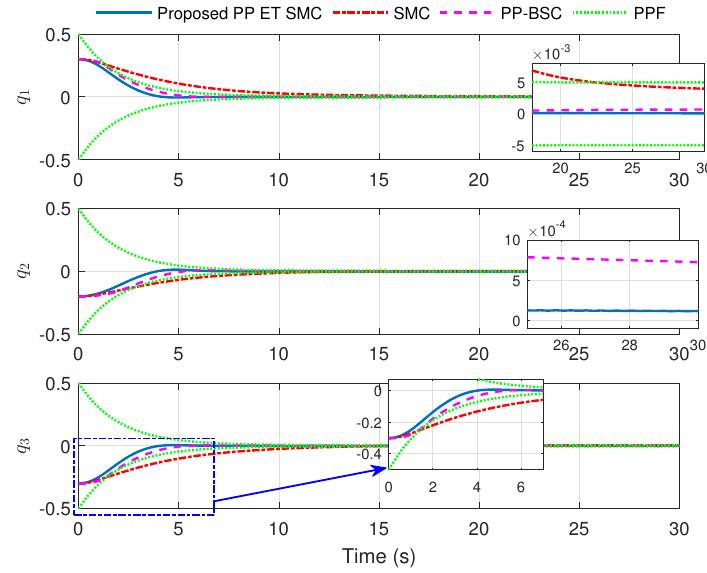
Figure 4. Quaternion response.